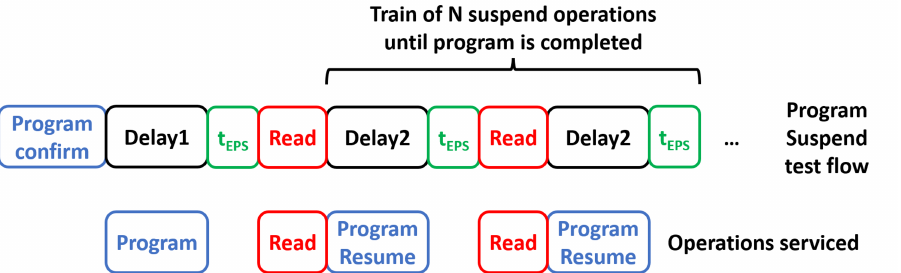
Figure 5. The program suspend test flow exploited in this work to explore theoperation